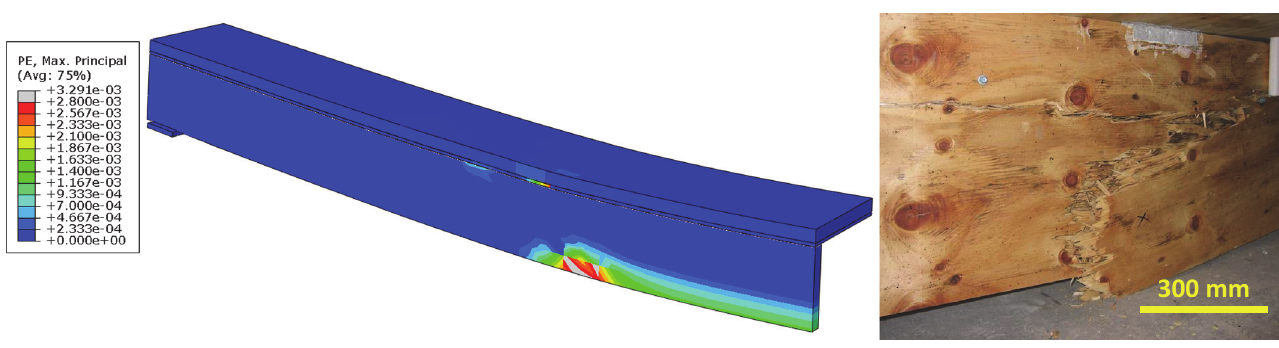
Figure 13: Plastic strain distribution displayed in the simulation compared to LVL bending tension failure obtained at one-third span of the beam G1 [11].